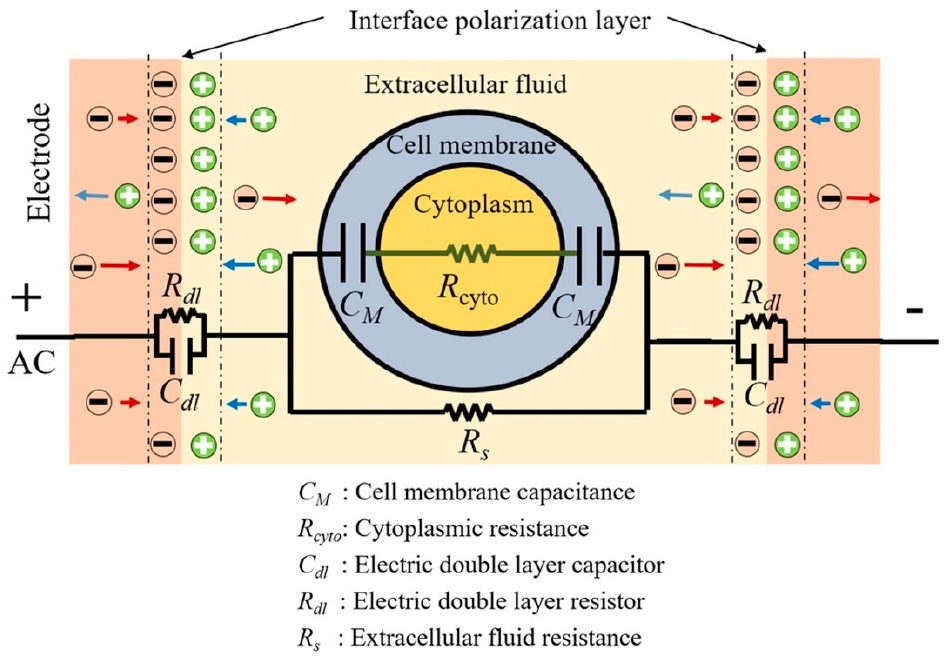
Figure 5. Equivalent circuit diagram of single cell suspension. Reproduced with permission from [102] without modification. Copyright 2020 John Wiley and Sons.